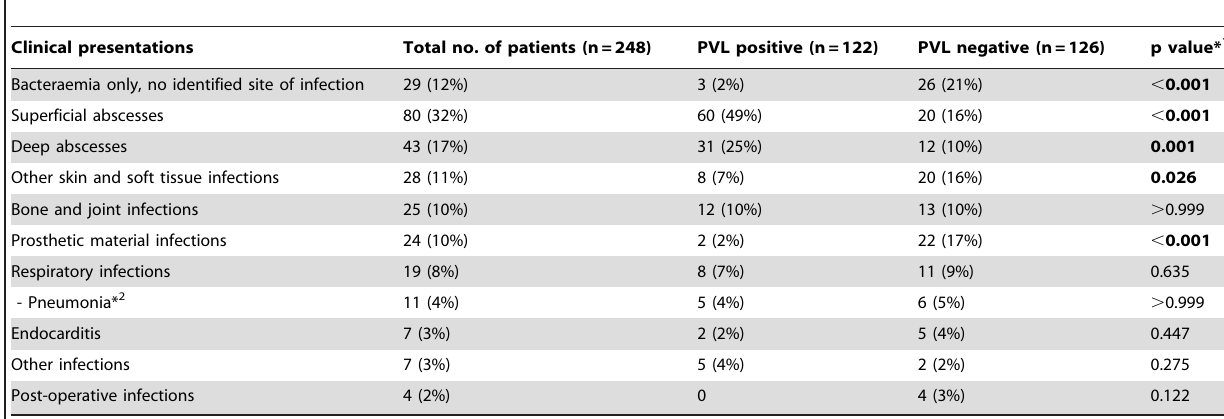
Table 3. Association between clinical presentation and presence of Panton-Valentine Leukocidin (PVL) in the infecting isolate for 248 patients with S. aureus infection.